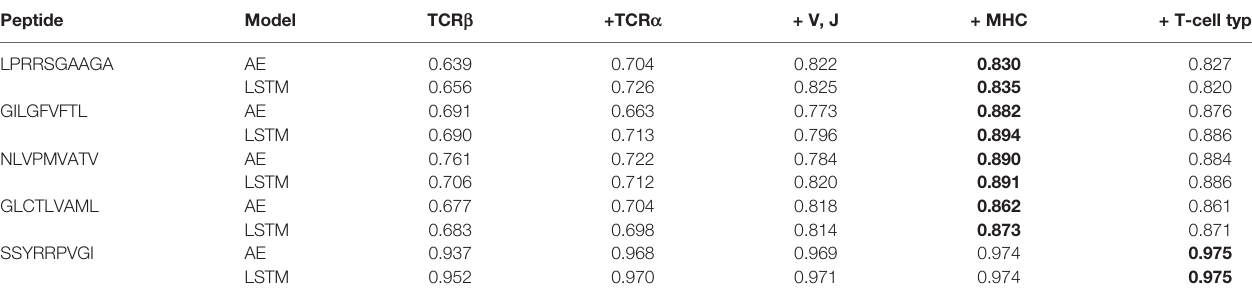
TABLE 3 | Area Under Curve (AUC) of Single Peptide Binding (SPB) prediction task of the fi ve most frequent peptides in McPAS (20) database. Peptide